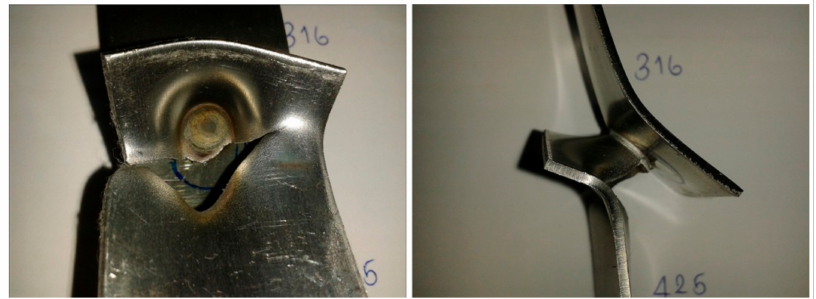
Figure 7. Tensile surface fracture of the pullout failure mode.